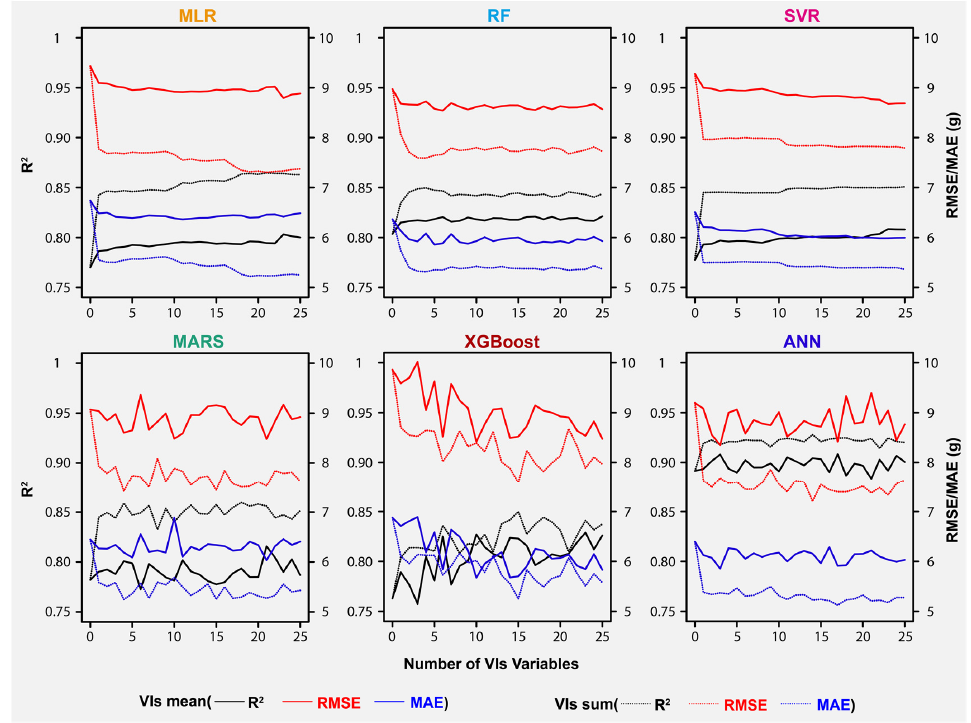
Figure 9. Validation accuracy of six regression techniques using different numbers of input VIs. The number “0” indicates that only geometric parameters were used for the biomass prediction.